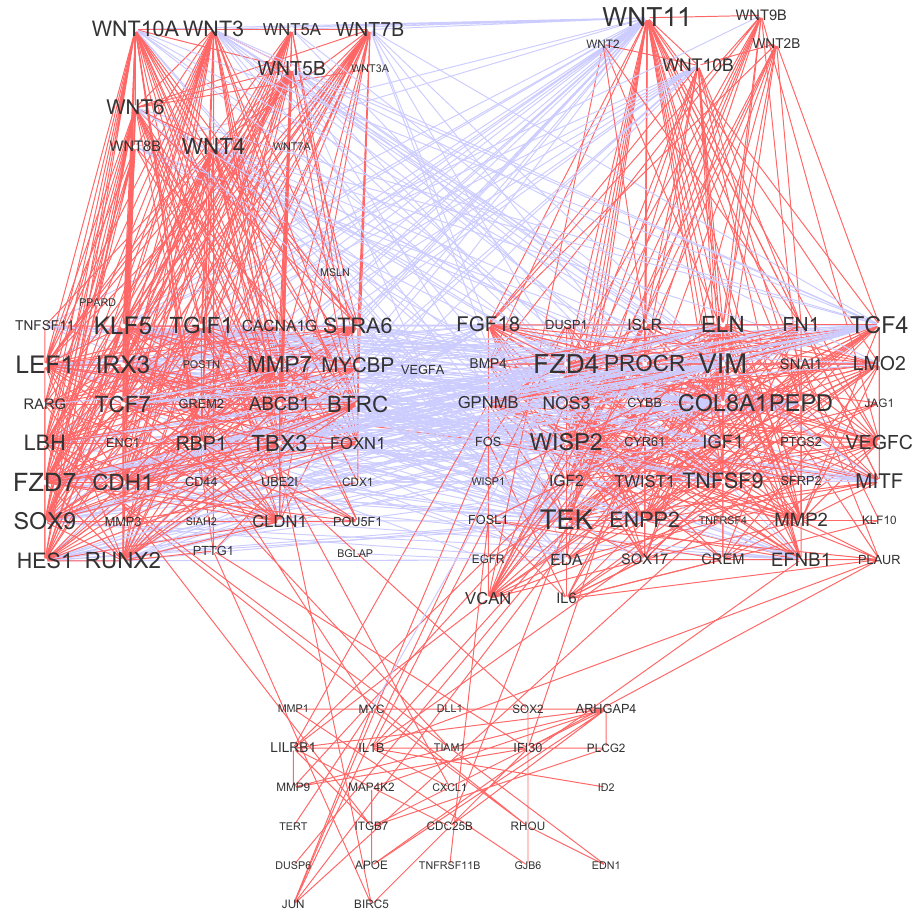
Figure 4. Network showing dependency of different Wnt target genes expression levels on Wnt ligands. Target genes can be separated in two essentially antagonistic clusters controlled by Wnt ligands from clusters #4 (left) and #1 (right) as shown on Fig. 3. However, there is also a low-connected cluster of target genes which seems to be correlating with target genes of both